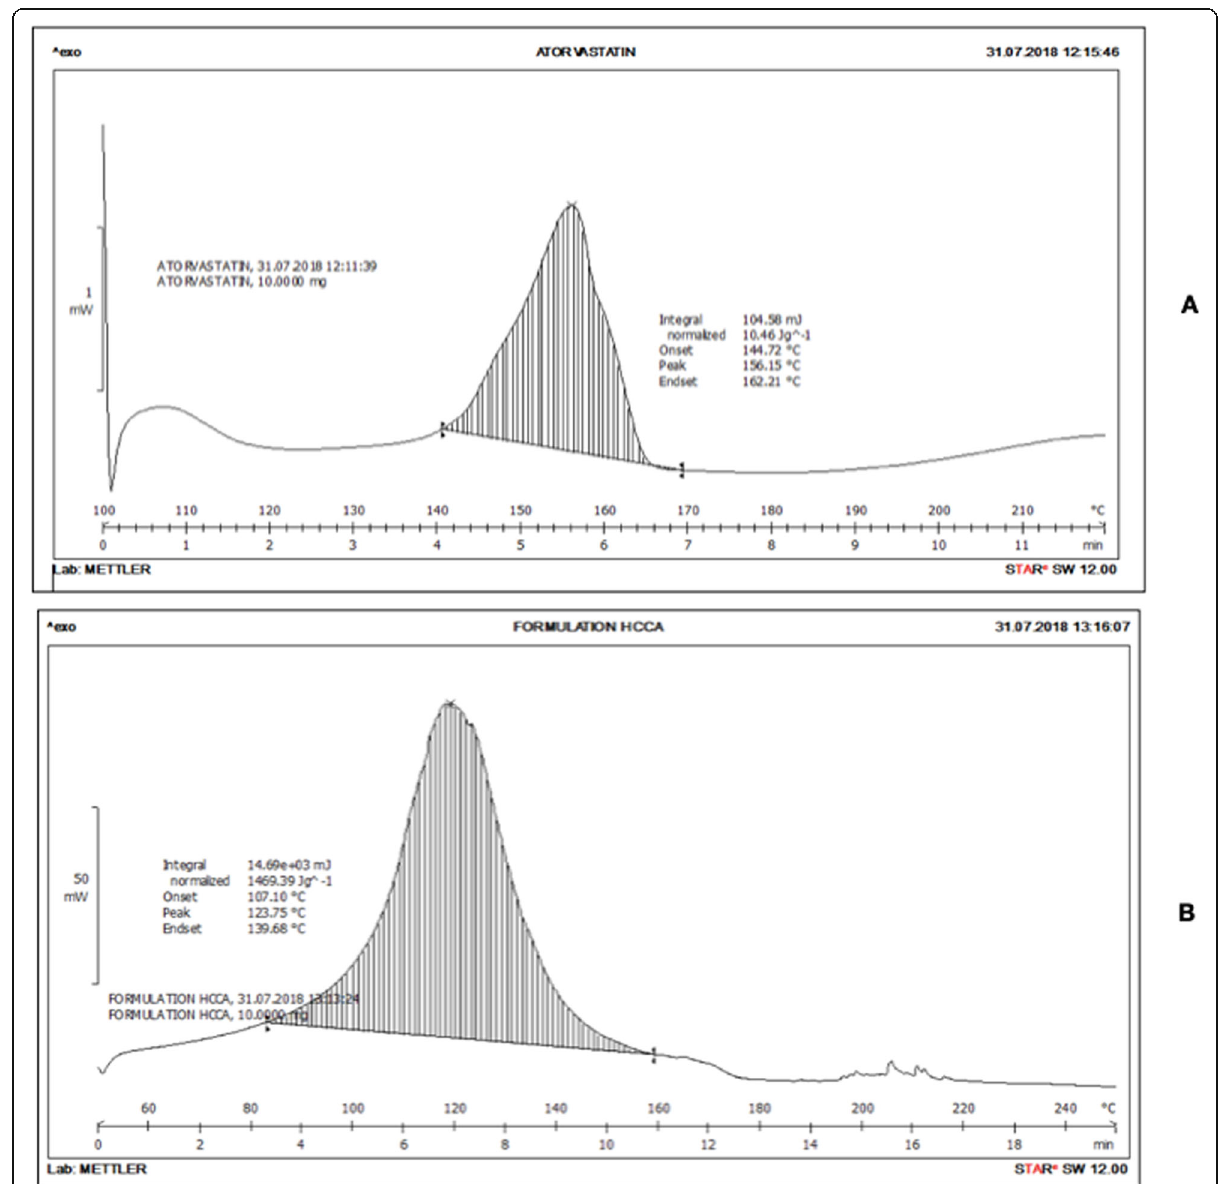
Fig. 3 DSC thermogram of prepared bioscaffold. a Pure drug atorvastatin. b Atorvastatin-loaded chitosan-hydroxyapatite